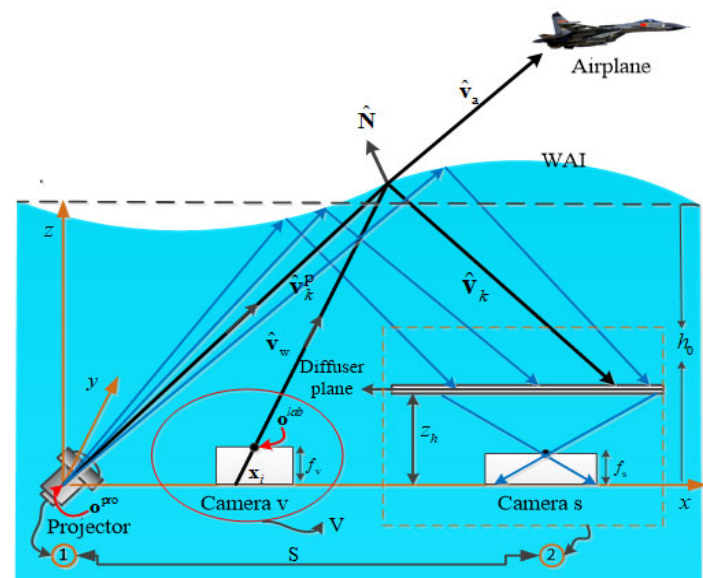
Figure 4. Geometry of the image-restoration model via structured light projection, comprising a structured light projection system S and a viewing camera V. Component S consists of a projector, diffuser plane, and a camera s.